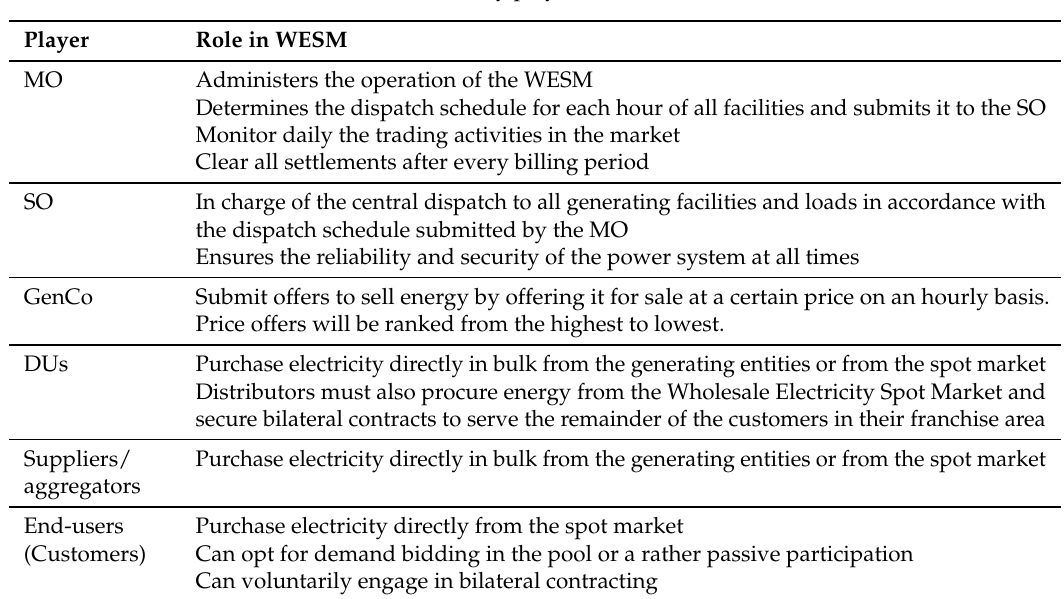
Table 2. Key players in